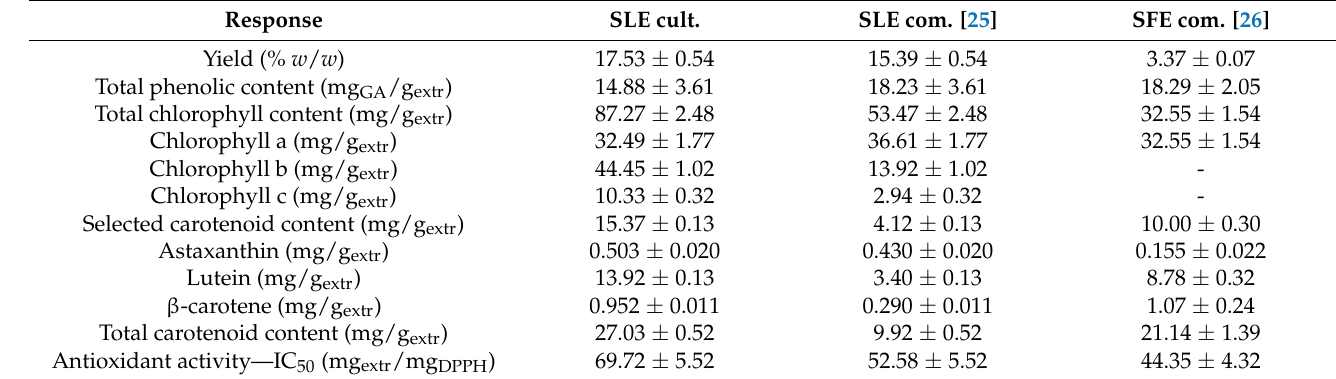
Table 2. Extract characterization of SLE and SFE derived from C. vulgaris biomass.